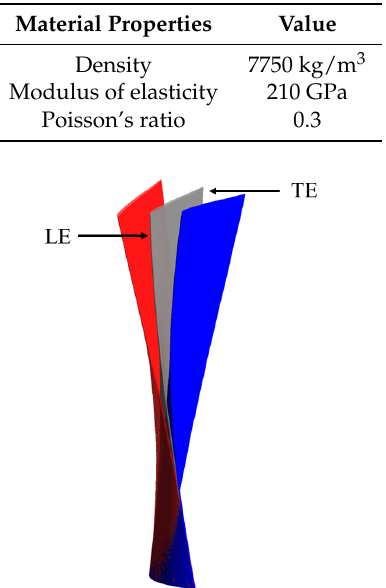
Table 1. Material properties of the rotor blade.